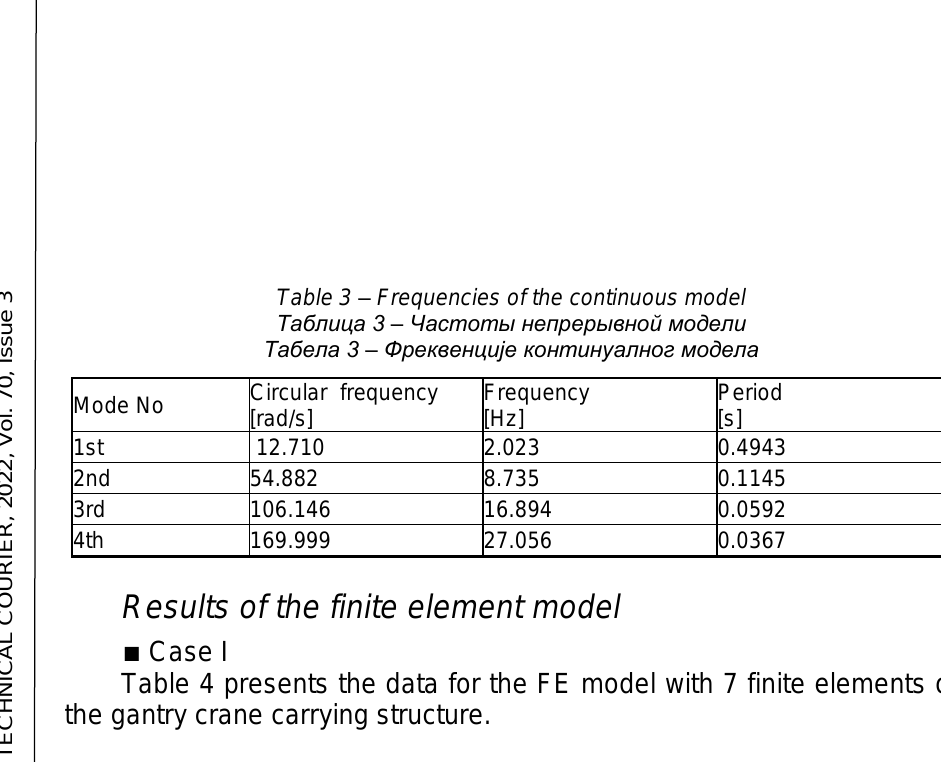
Table 4 – Characteristics of the model with 7 finite elements